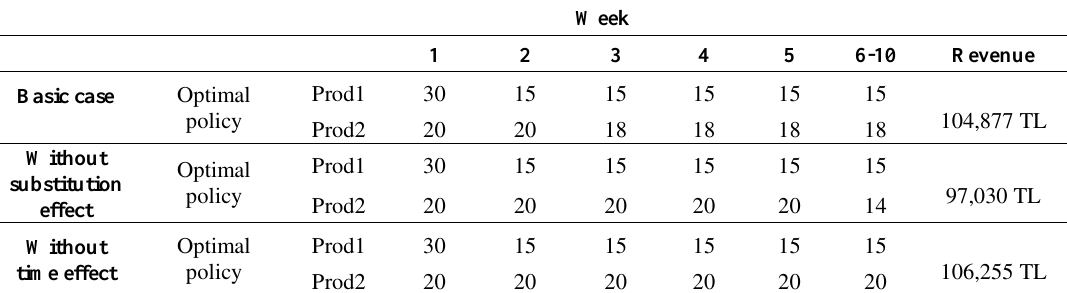
Table 3. Optimal policies obtained by the posterior